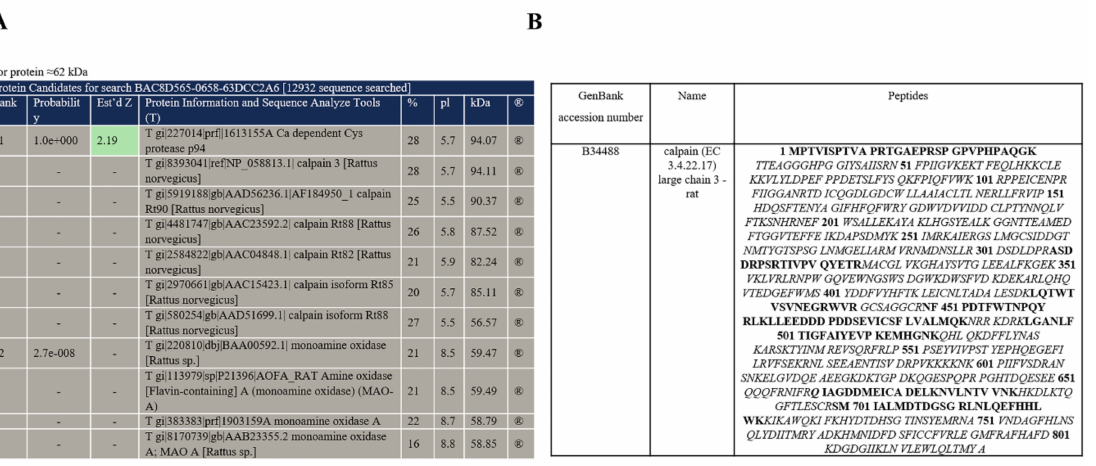
Figure 2. Identification of 60–62 kDa phosphoprotein in RBM by mass spectrometry as Calpain 3 (CAPN3). ( A )—The search of protein candidates. ( B )—Analysis of the amino acid sequence of phosphoproteins with molecular weights of 60–62 kDa according to the mass-spectrometric method of analysis. Matching amino acid sequences are shown in black bold